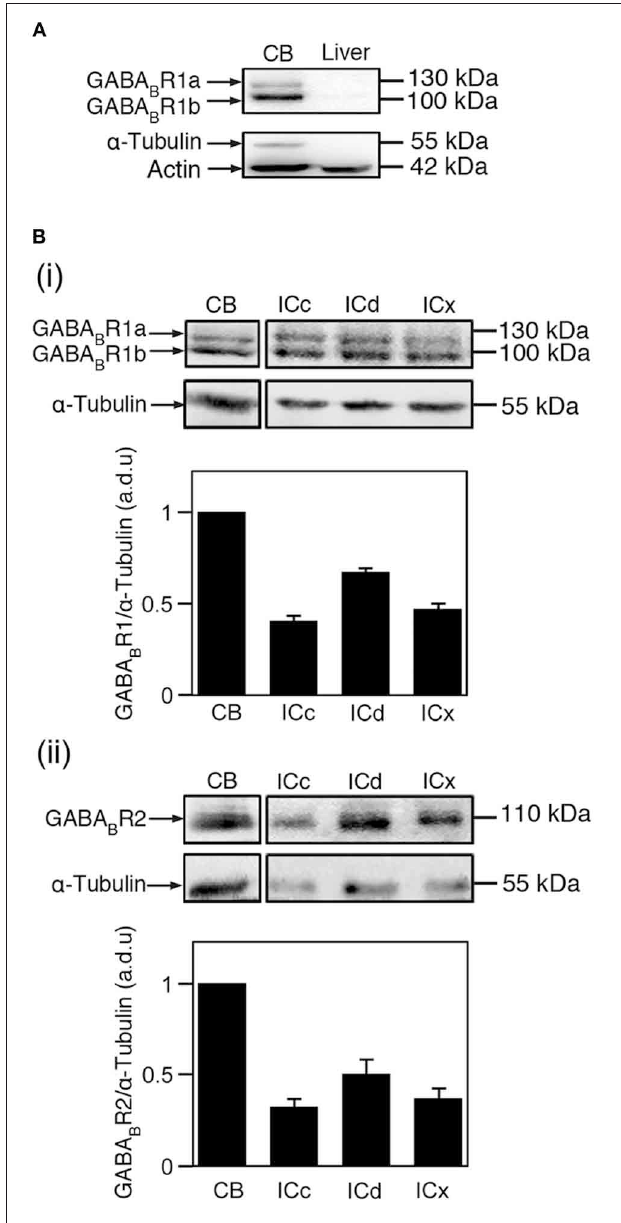
FIGURE 1 | Immunoreactivity to antibodies against the GABA B R1 and GABA B R2 subunits as revealed by Western blots. (A) Western blots obtained by using the antibody against the GABA B R1 subunit and tissues from the cerebellum and the liver (top panel). Actin was used as a general loading control (lower band of the lower panel) and α -Tubulin was used as a brain tissue-specific loading control (upper band of the lower panel). Two bands with molecular weights of 100 and 130kDa are revealed in the blot for cerebellar tissue. (B) Western blots showing GABA B R1 (i) and GABA B R2 (ii) immunoreactivities in the cerebellum, ICc, ICd, and ICx. In (i) and (ii) , blots reflecting α -Tubulin immunoreactivity are shown below the blots reflecting the GABA B R1 and GABA B R2 immunoreactivities. The ratio between the OD of a GABA B R1 or GABA B R2 band and the OD of an α -Tubulin band was obtained for each of the four neural structures in each animal. The ratio from the cerebellum was used for normalization. Group results based on ratios from four animals are shown in bar charts in B(i) and B(ii) . Error bars indicate standard